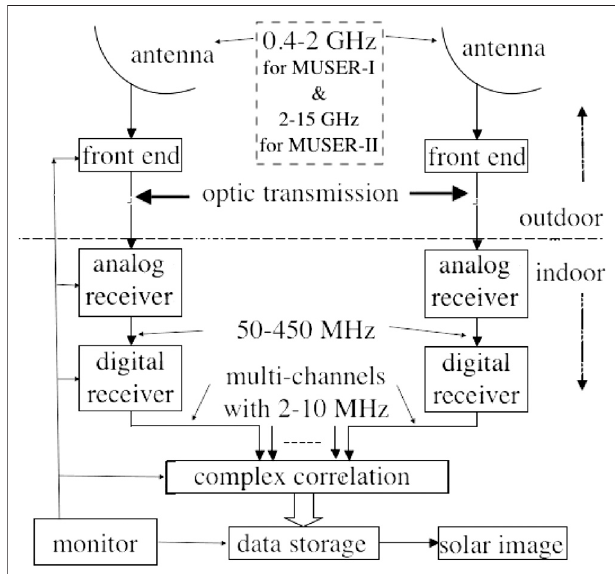
FIGURE 3 | The schematic system block diagram of MUSER-I and MUSER-II. Both have a similar system structure except that the radio frequency (RF) input is 0.4 – 2 GHz for MUSER-I whereas 2 – 15 GHz for MUSER-II (Yan et al.,